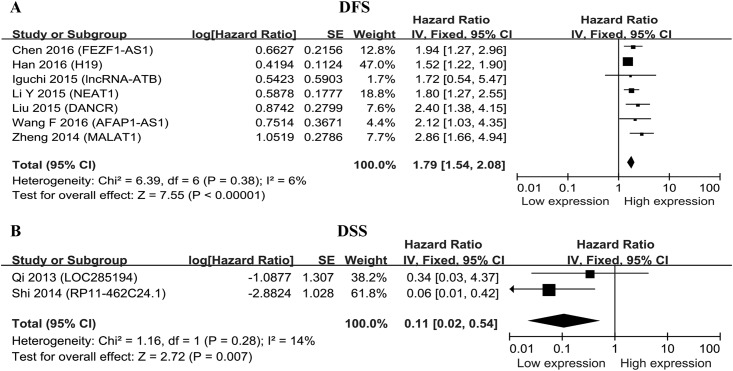
Meta-analysis of the pooled HRs of DFS and DSS for CRC patients.A.DFS; B. DSS.